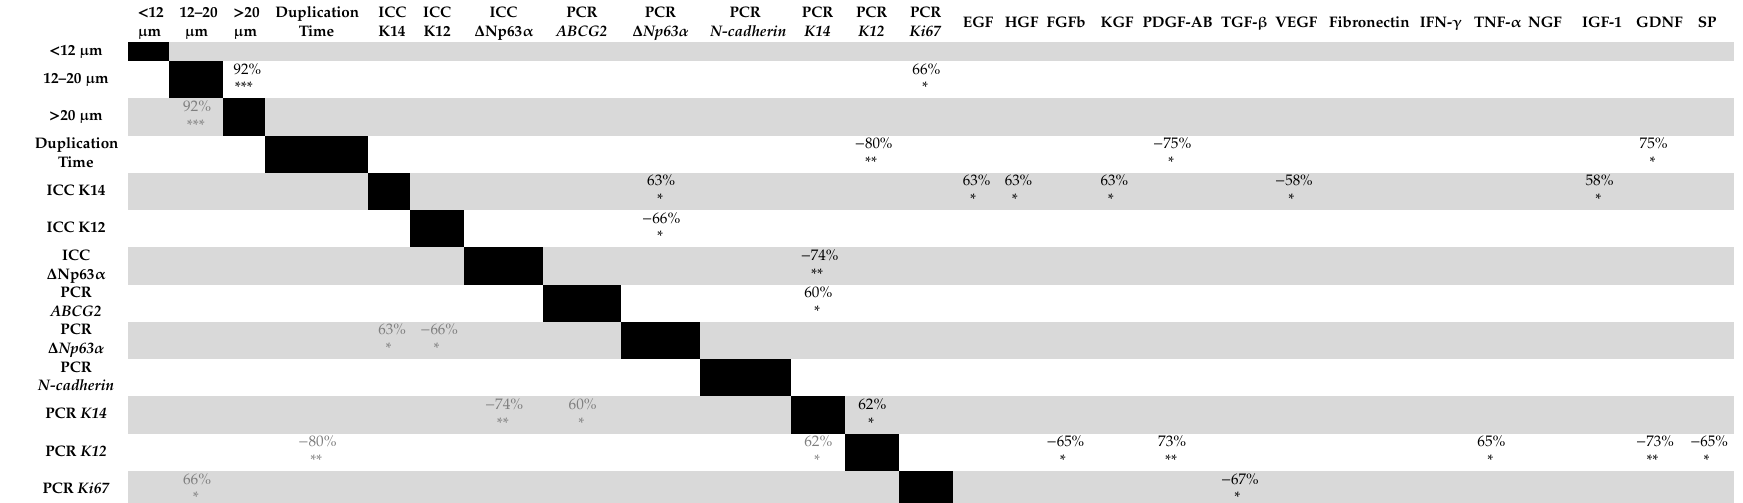
Table 2. Correlations of variables associated with cells cultured with human sera, between them, and with respect to human sera’s growth factors and molecules. < 12 12–20 µ m µ